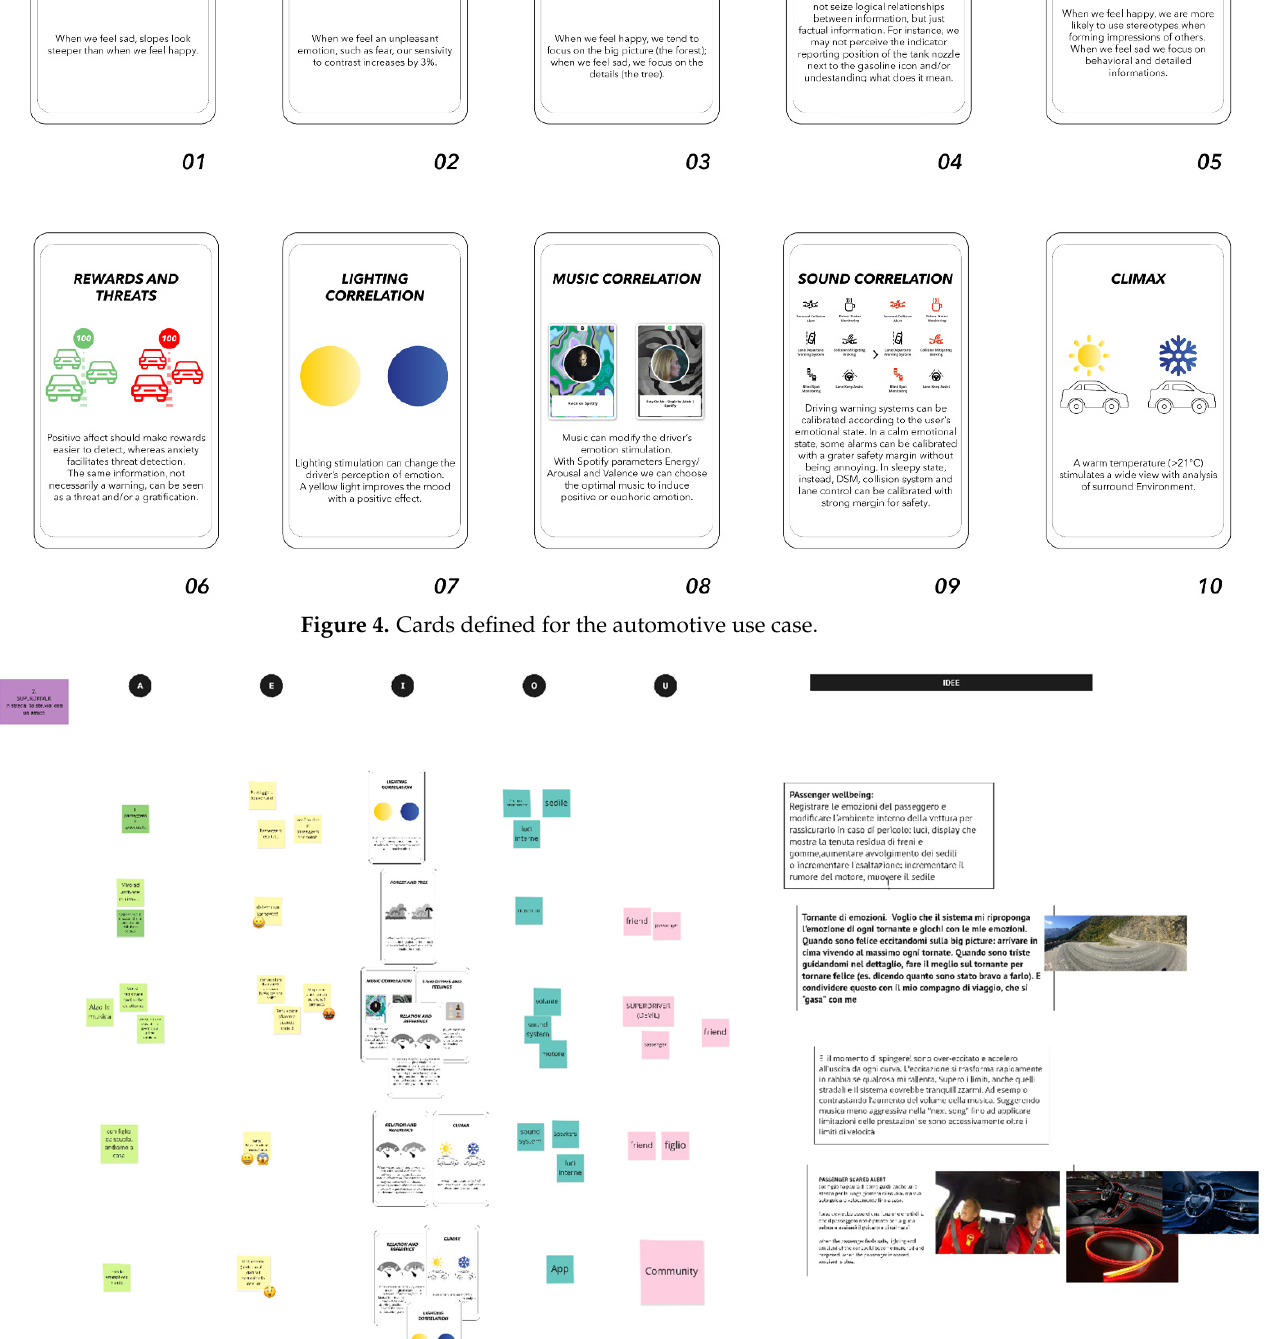
Figure 5. The conclusion of the ideation phase for the Superdriver persona.